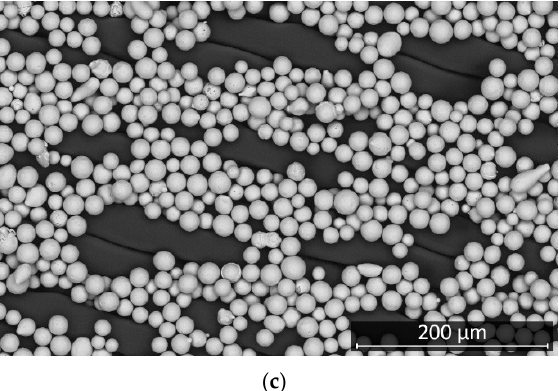
Figure 1. Scanning electron microscopy images of solder paste grains: ( a ) Type-3 solder paste; ( b ) Type-4 solder paste; ( c ) Type-5 solder paste.